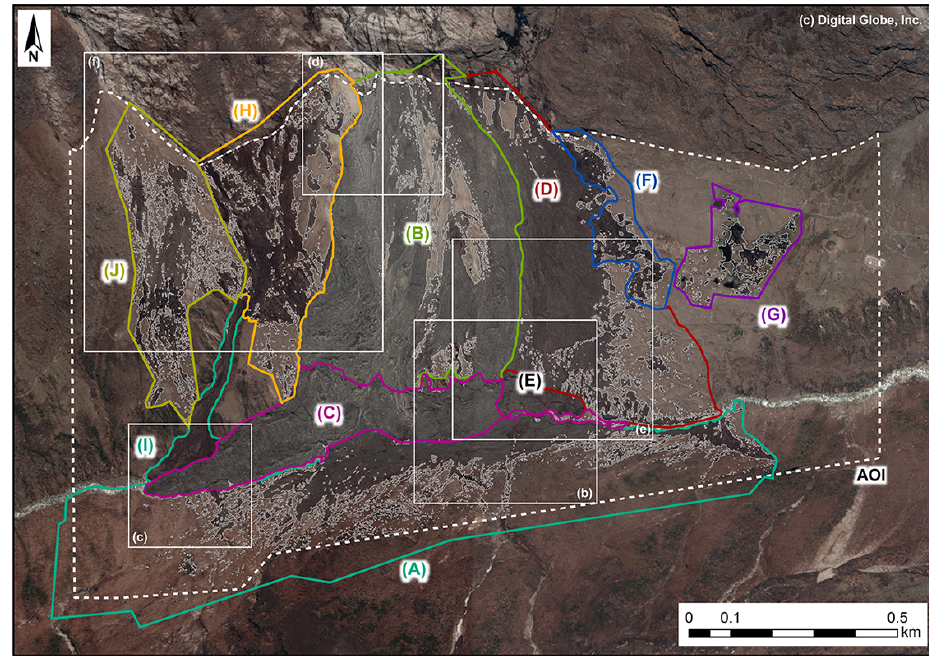
Figure 3. Avalanche-induced sediment deposition observed with WorldView-3. The dotted rectangle is the area of interest of this study, within which sediment depositions are classified from A to J. Squares correspond to the close-up view in Fig.